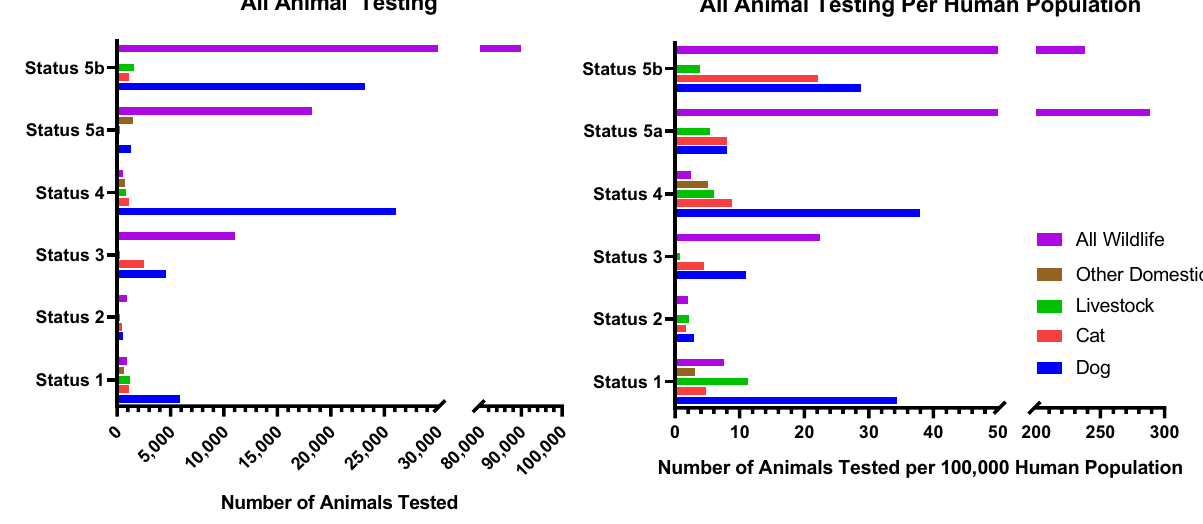
Figure 1. Animal testing rates stratified by WHO Rabies Status. An increase in Rabies Status from 1 to 5 is representative of a higher degree of dog rabies control. The x-axis is segmented so that lower testing numbers of animals can be